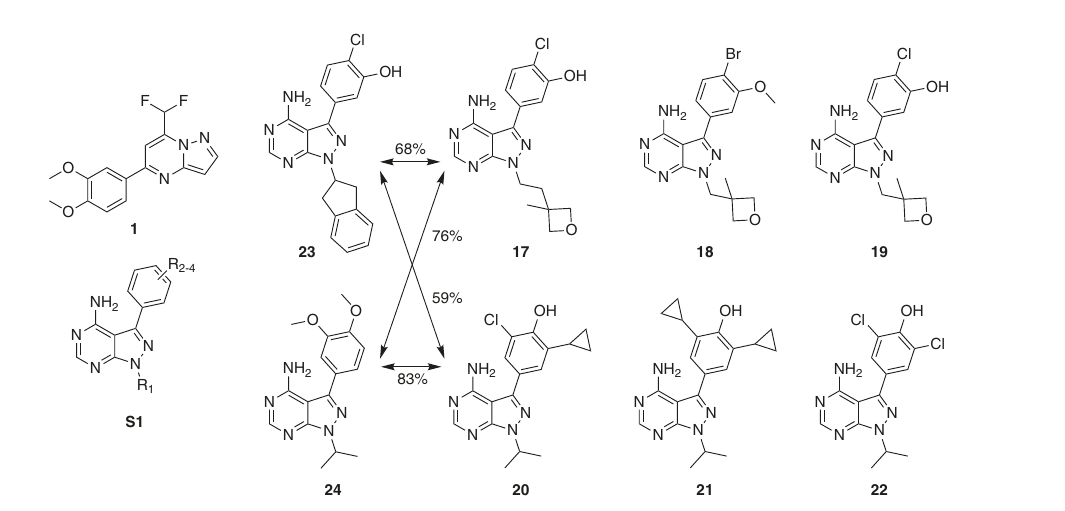
Fig.5|Chemicalstructuresofbioactiveligands. Computer-generatedmolecule 1 isacommerciallyavailablePI3K γ ligandidenti fi edbythechemicallanguagemodel. Percent values (Tanimoto coef fi cient) re fl ect the similarity of the synthesized